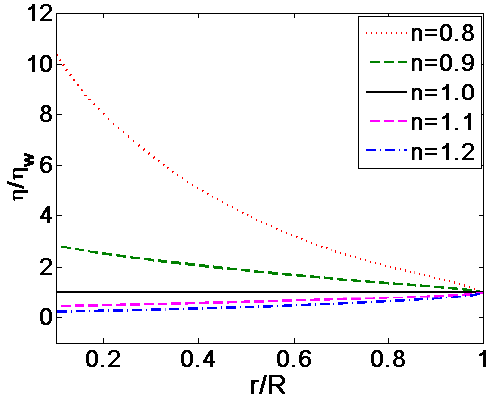
Figure 5. The comparison of dimensionless dynamic viscosity distributions generalized with the respective magnitude of dynamic viscosity at the channel wall η w for various values of flow behavior respective magnitude of dynamic viscosity at the channel wall w  for various values of flow index n ( K = 10, ξ = − behavior index n ( K = 10,  = − 4).